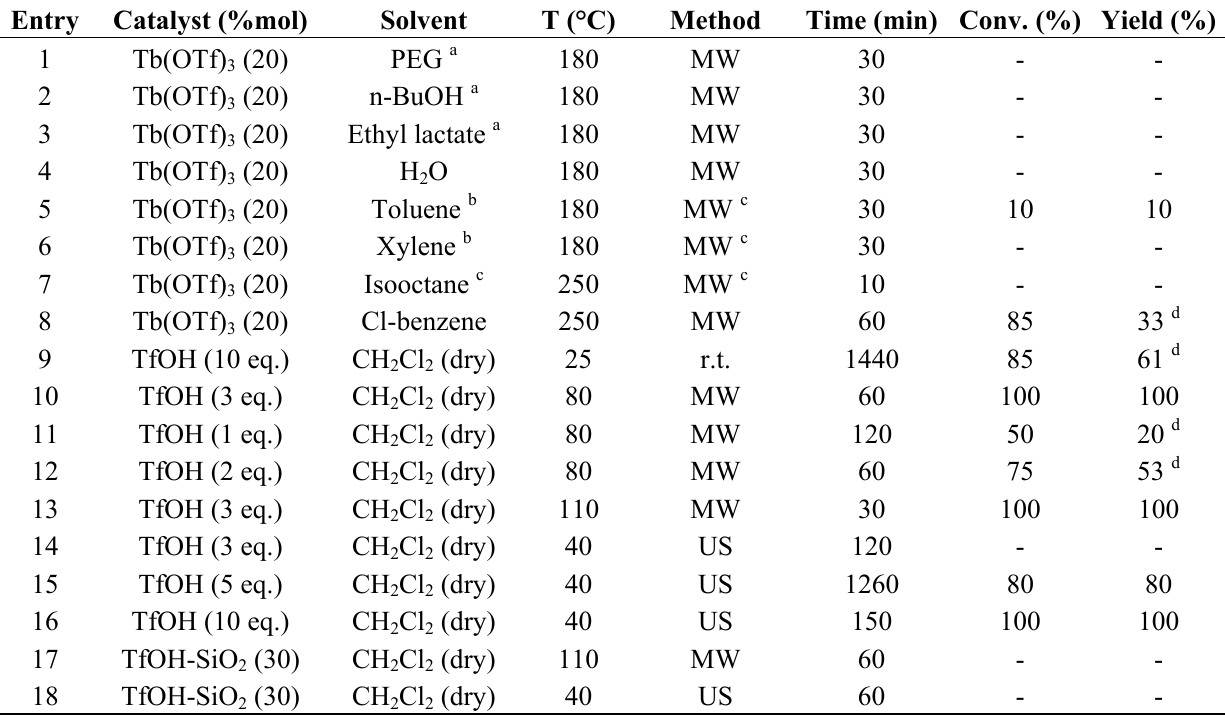
Table 1. MW vs. US in the intramolecular Friedel-Craft acylation of 3-(4-methoxyphenyl) propionic acid ( 1